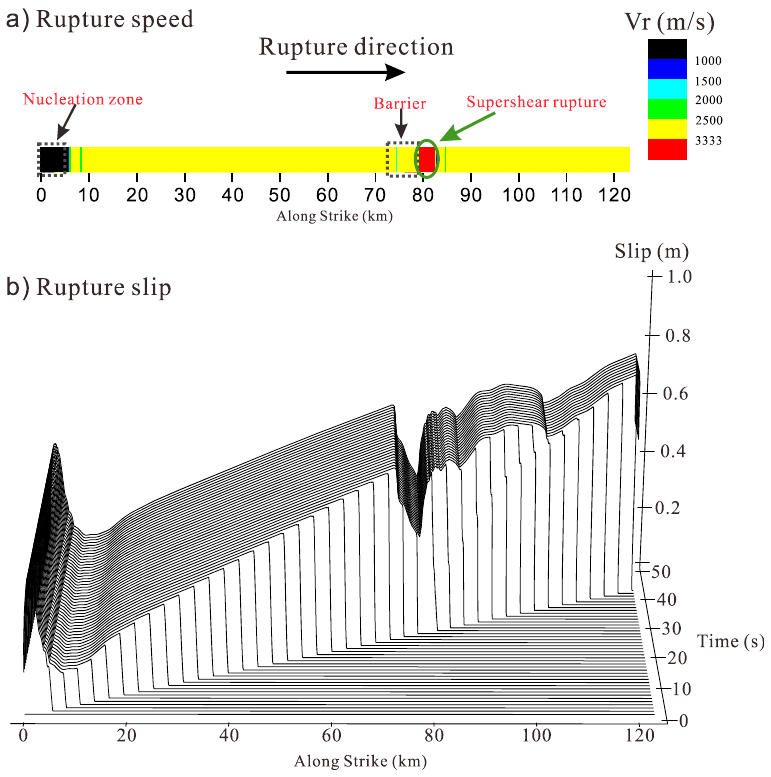
Figure 4. ( a ) Distribution diagram of the rupture speed of the fault surface of the RS model (a model that uses the rate-state friction law to simulate the effect of a barrier on rupture propagation). ( b ) Distribution diagram of the slip along the interface over time.